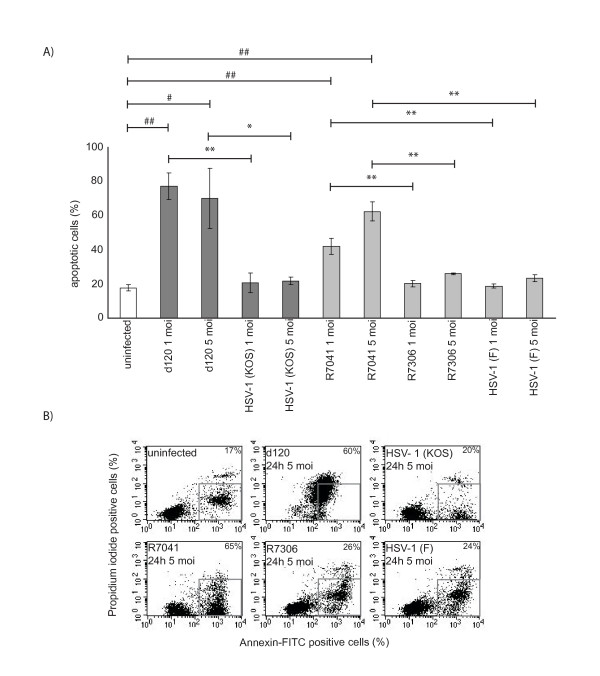
The d120 and R7041 virus infections induced apoptosis in U937 cells. The percentage of apoptotic cells was analyzed at 24h p.i. with Annexin V/propidium iodide double staining and flow cytometry. A) Percentage of apoptotic U937 cells. The level of apoptosis was significantly increased in d120-infected cells when compared to its parental virus HSV-1(KOS)-infected (1 and 5 moi) cells. Also, the level of apoptosis was significantly increased in R7041-infected cells when compared to its rescue virus R7306 (1 and 5 moi) and HSV-1(F)-infected (1 and 5 moi) cells. The bars represent the mean level of apoptotic cells ± SD from three independent experiments. The statistical significances of the differences in the level of apoptosis in comparison of the deletion viruses versus the parental viruses are marked as * (*:p<0.05, **:p<0.01) and in comparison with uninfected cells as # (#:p<0.05, ##:p<0.01). B) Representative flow cytometry dot plots showing Annexin V/propidium iodide double staining of uninfected, d120, its parental virus HSV-1(KOS), R7041, its rescue virus R7306 and HSV-1(F)-infected cells. The apoptotic cell population with positive staining for Annexin V and negative staining for propidium iodide is gated from the dot plots.